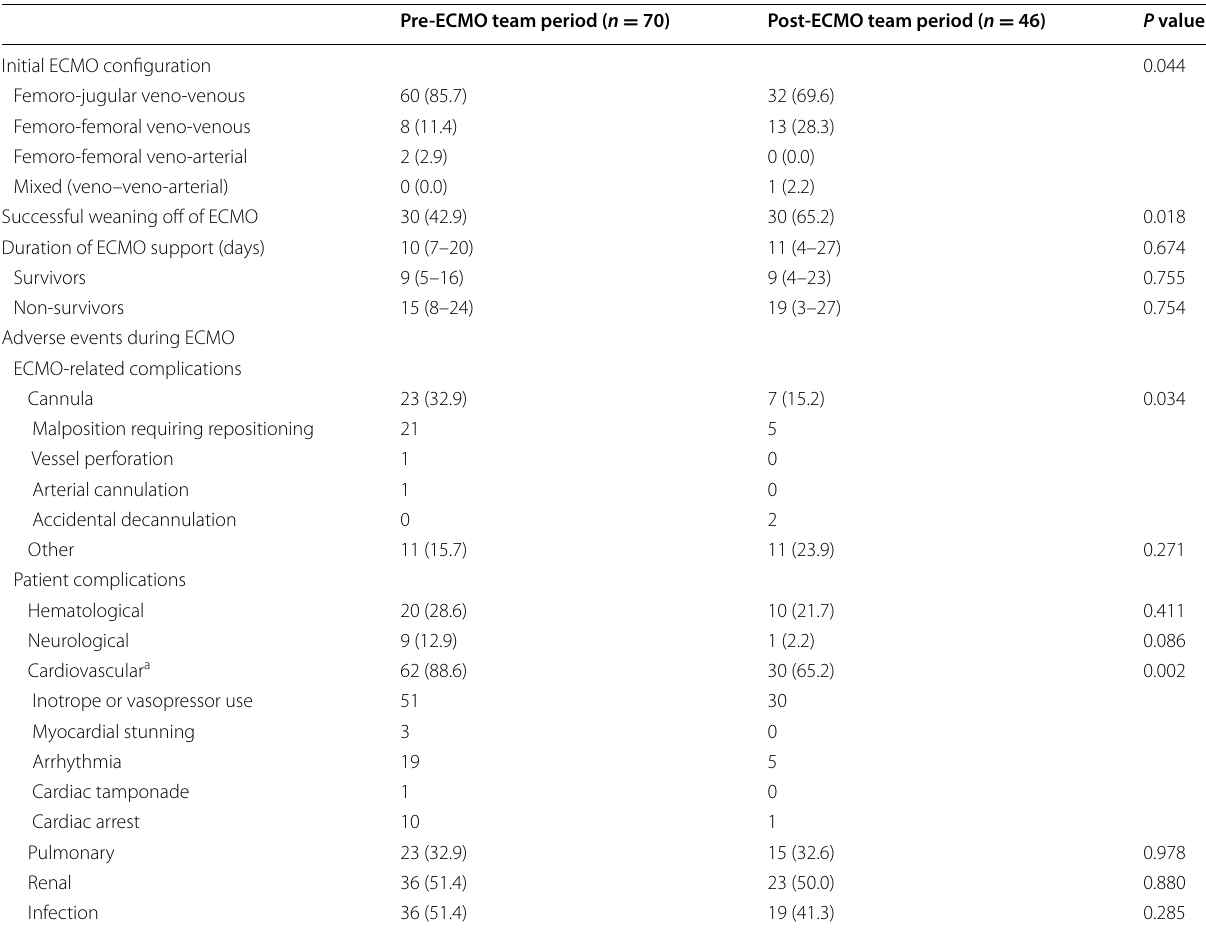
Table 3 Management of extracorporeal membrane oxygenation